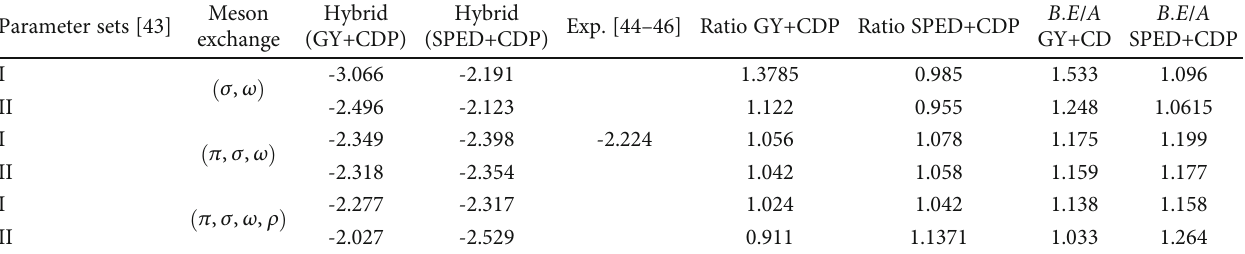
Table 3: The ground-state energy of deuteron with the hybrid model related to quark and meson degrees of freedom.